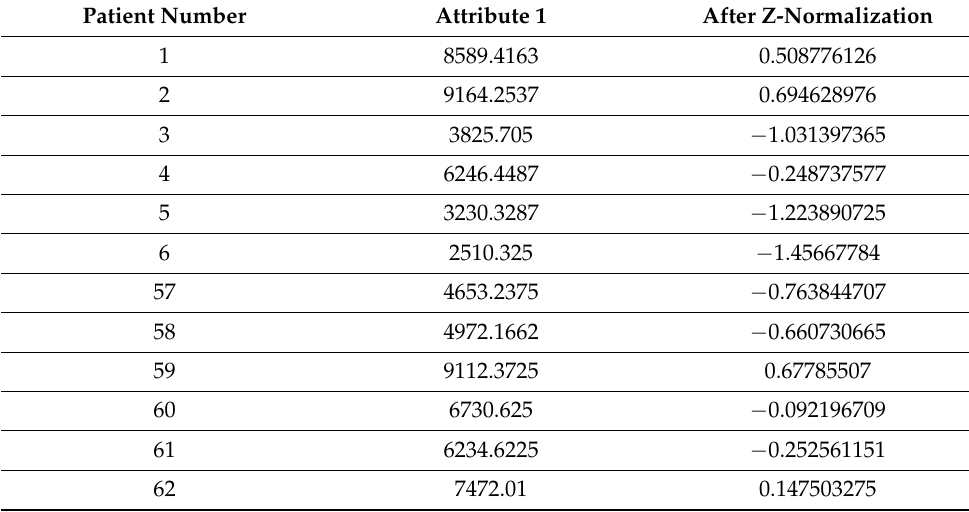
Table 1. Z-normalized values of 12 patients corresponding to Attribute